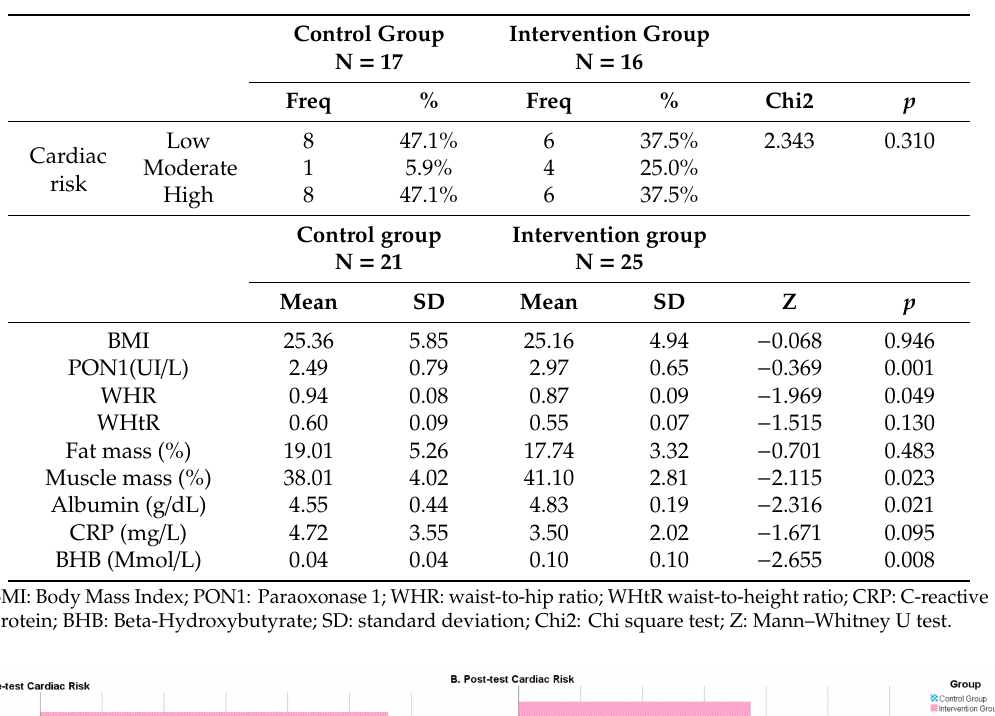
Table 2. Comparison between di ff erent groups post-test.